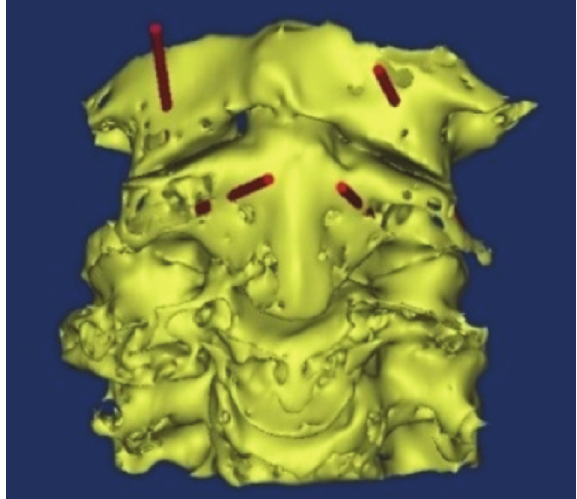
Three-dimensional coronal view. Red cylinders represent Fig. 3: the path of the screws.